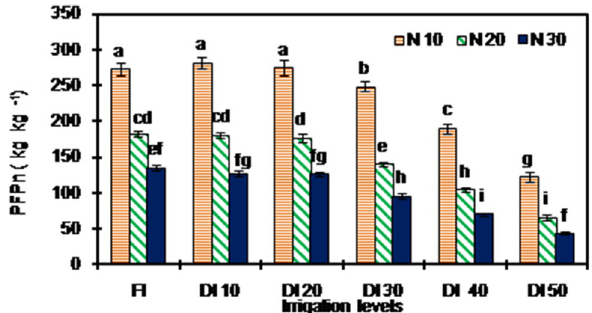
Figure 4. Nitrogen-use efficiency of peanut under different irrigation and nitrogen application rate treatments [Data points are mean ± standard error, n = 9 (3 × 3; 3 growing seasons and 3 replications per treatment)].Error bars are standard error. Bar followed by different letter/s are significantly different at P < 0.05 level according to LSD. PFP n : partial factor productivity of N. The details of treatments are given in Table 1.